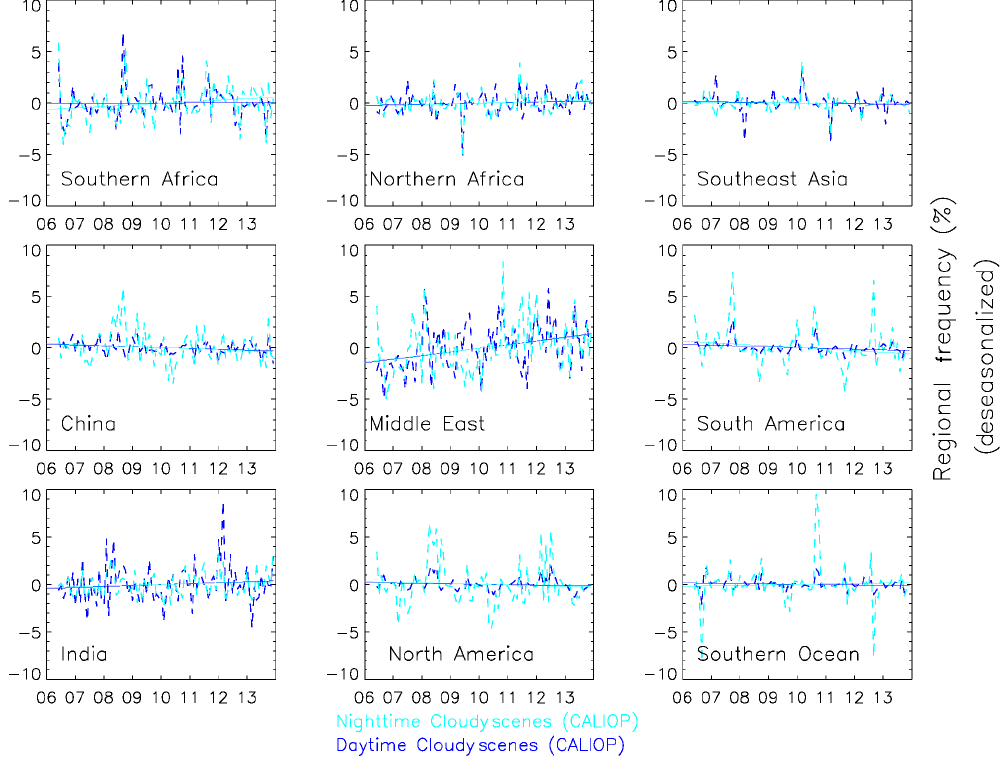
Figure 15. The deseasonalized monthly and regionally averaged cloudy-sky frequency of ACA occurrences for the nine different regions outlined in Fig. 3 and explained in Table 3. The dashed lines show the monthly frequency over the regions and the solid lines show the trend lines computed for each region, with the x axis representing the year of the study. The CALIOP nighttime analysis is shown in aqua marine and the daytime analysis is shown in dark